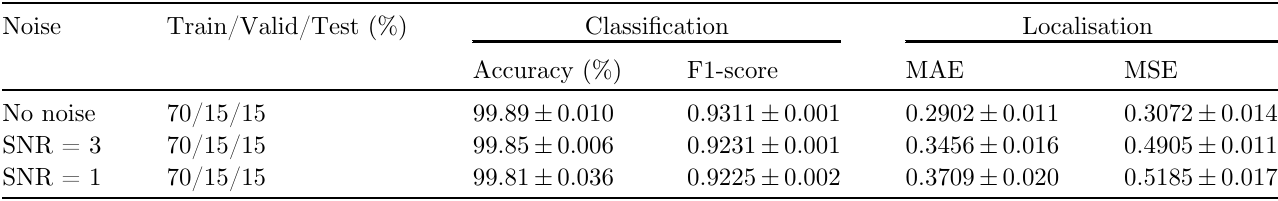
Table 2. Results of the proposed 3D-CNN for the classi fi cation and localisation of perturbation type and source location ( i, j, k ) with the corruption of input signals at SNR = 3 and SNR = 1. Noise